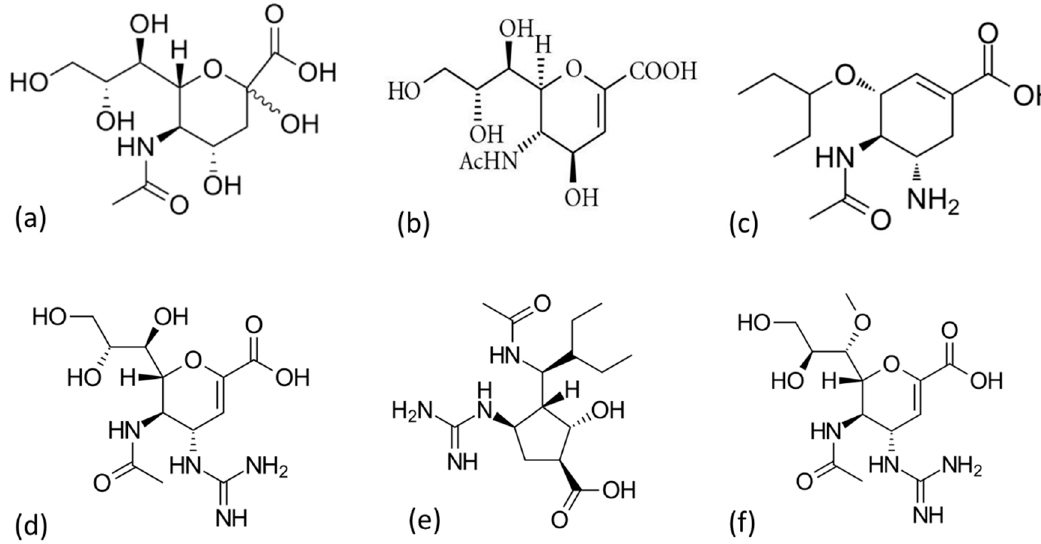
Figure 9. Chemical structure of sialic acid for treatment and prophylaxis of influenza infection ( a ), DANA ( b ), zanamivir ( c ), oseltamivir ( d ), peramivir ( e ), and laninamivir ( f ) (prepared by authors).